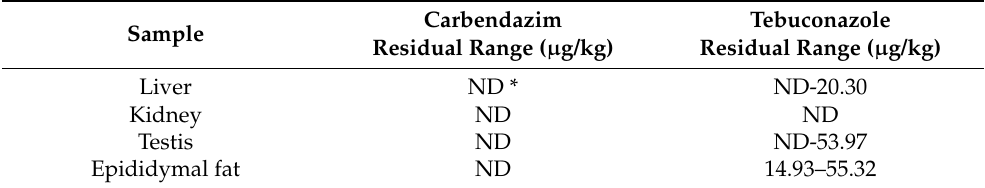
Table 5. Concentration of carbendazim and tebuconazole in mouse tissues after 4 weeks of adminis- tration at the 100-fold ADI